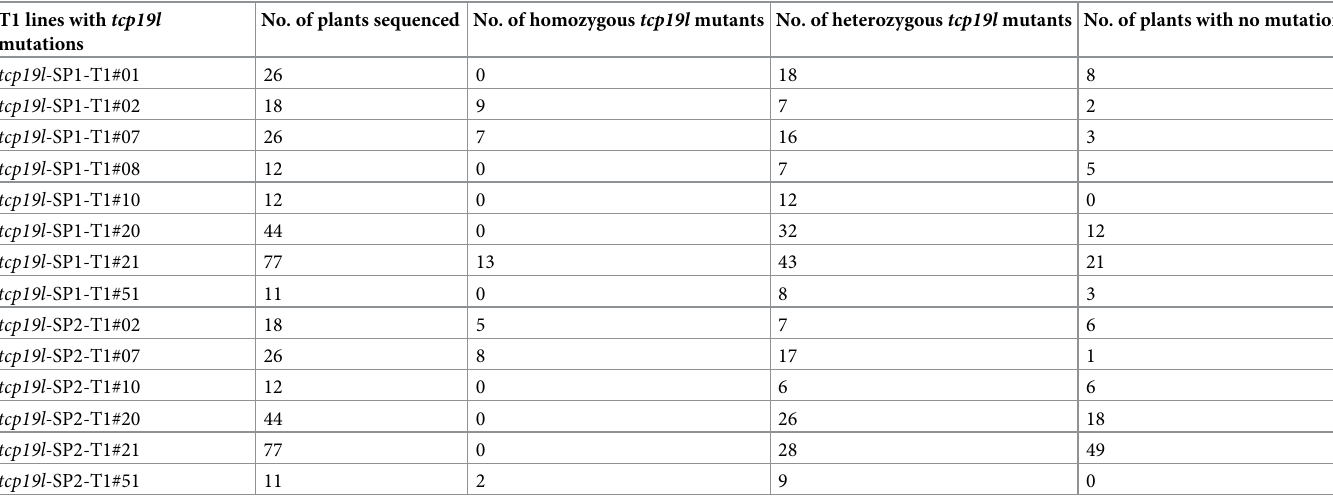
Table 1. CRISPR/Cas9-mediated targeted mutagenesis of GmTCP19L in the T1 generation. T1 lines with tcp19l No. of plants sequenced No. of homozygous tcp19l mutants No. of heterozygous tcp19l mutants No. of plants with no mutations